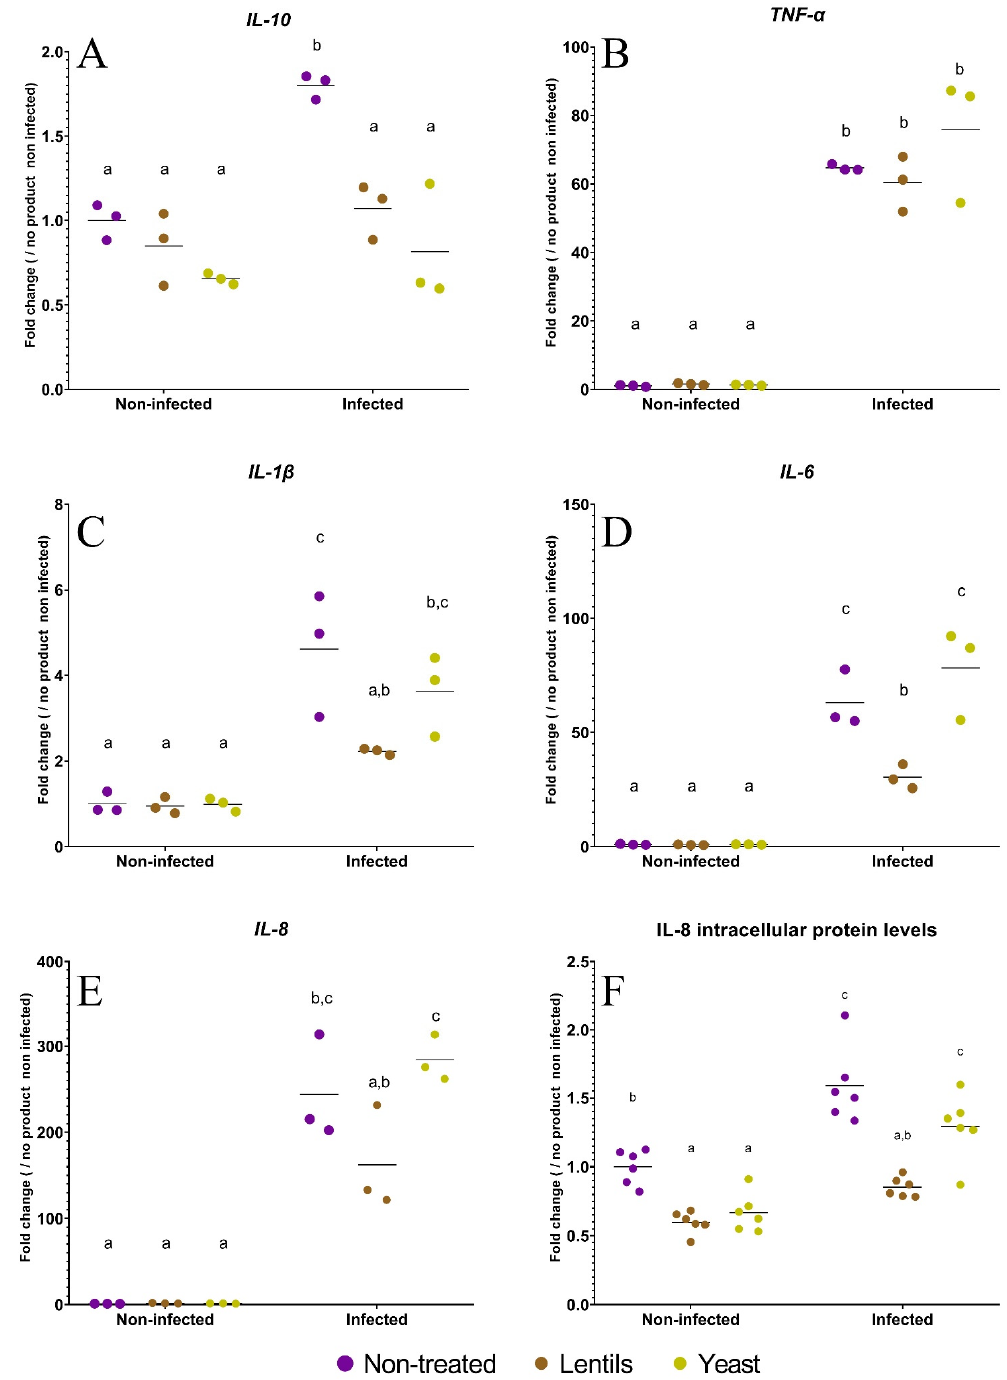
Figure 5. Modulation of host innate immune related genes by fiber-containing products. Caco- 2/HT29-MTX cells were infected with ETEC strain H10407 (10 7 CFU · mL − 1 , MOI 100) after a 3 h pre-treatment with the lentil extract (brown dots, ‘lentils’) or specific yeast cell walls (yellow dots, ‘yeast’). Non-infected and non-treated conditions (purple dots, ‘non-treated’) were used as control experiments. Cytokine ( IL-10 , TNF- α , IL- β , IL-6, and IL-8 )-related gene expressions were analyzed by RT-qPCR ( A – E ), and the interleukin-8 (IL-8) intracellular protein level was measured by an ELISA assay ( F ). Results are expressed as fold changes compared to the non-infected and non-treated control condition. The data represent the replicates of at least three independent experiments with their means. Results that are not different from each other according to Tukey’s multiple comparisons tests are grouped under a same letter ( p <